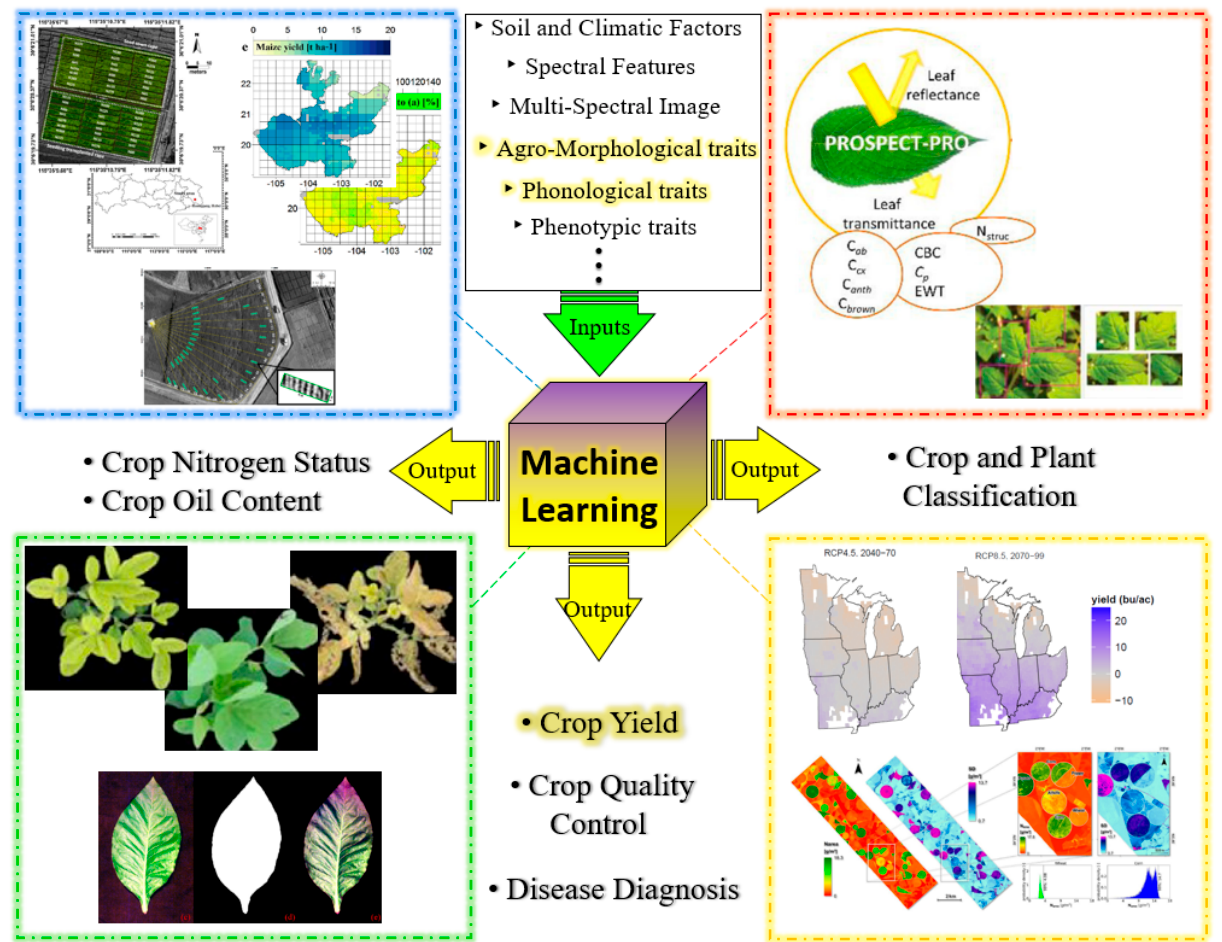
Figure 1. Overview of the potential agricultural research questions that have been investigated using ML modeling methods [54,55,62,79,81,89–92].